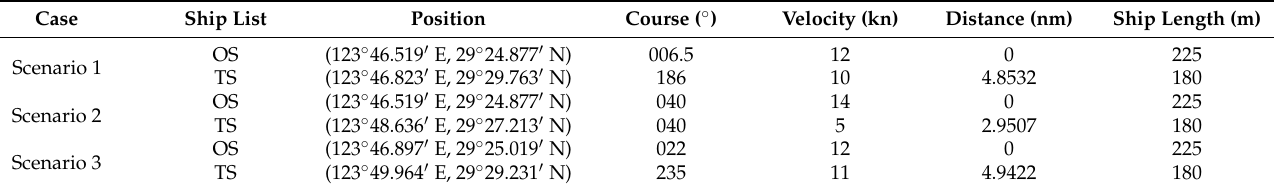
Table 1. Settings of two-ship scenarios.